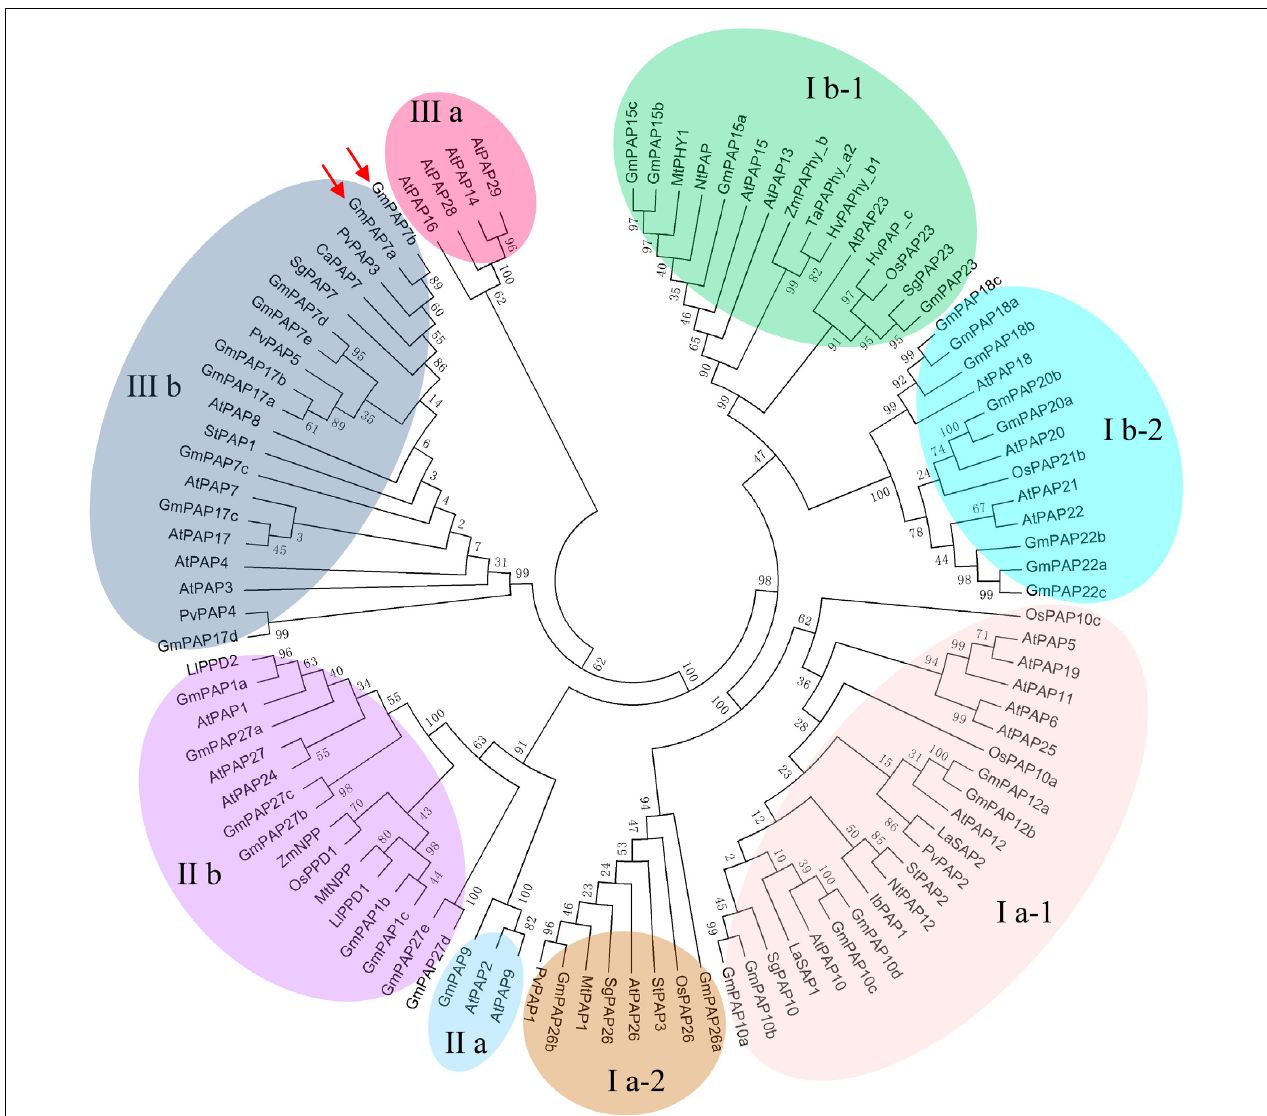
FIGURE 3 | Phylogenetic analysis of PAPs in different plant species. The first two letters of each PAP indicate the abbreviated species name. At: Arabidopsis thaliana , Gm: Glycine max , Pv: Phaseolus vulgaris , Os: Oryza sativa , Zm: Zea mays , Ll: Lupinus luteus , Ta: Triticum aestivum , Nt: Nicotiana tabacum , Hv: Hordeum vulgare , Sg: Stylosanthes guianensis , Mt: Medicago truncatula , La: Lupinus albus , St: Solanum tuberosum , Ib: Ipomoea batatas , Ca: Cicer arietinum . The phylogenetic tree was constructed by MEGA 5.01 program using the neighbor-joining method, with 1000 bootstrap replicates. The bootstrap values are indicated for major branches as percentages. GmPAP7a and GmPAP7b are indicated by red